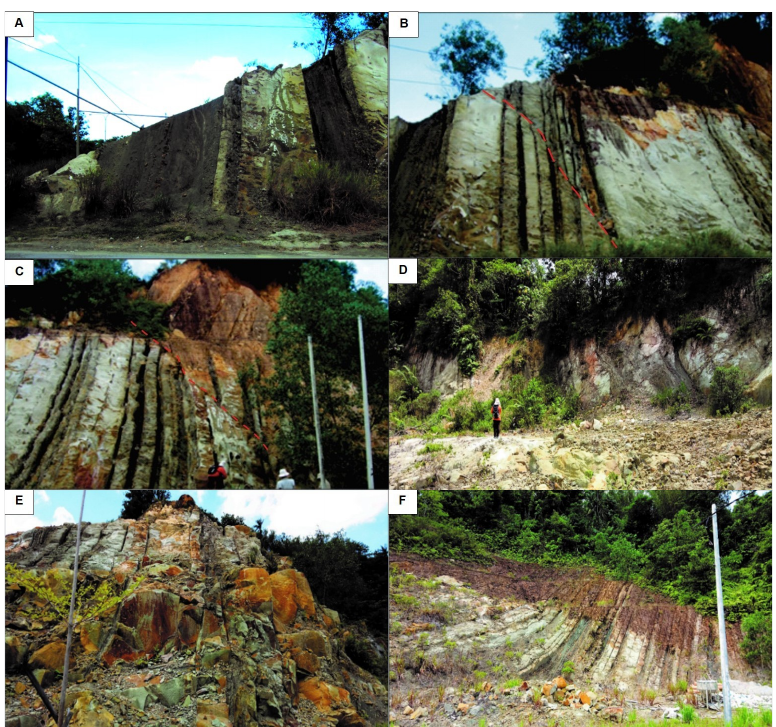
Figure 5. Characteristics of outcrop lithofacies in the study area. ( a ) Interbedded sandstone and mudstone and also thick sandstone outcrops at the L3. ( b ) Interbedded sandstone and mudstone, mudstone and massive sandstone with fault structure (red dashed line) at the upper area of L3 out- crop. ( c ) Sandstone with fault structure (red dashed line) at L3 area. ( d ) Massive sandstone was found in the L7 area. ( e ) Interbedded sandstone and mudstone are found in L6. ( f ) Thick sandstone outcrops show the amalgamation beds in L6.